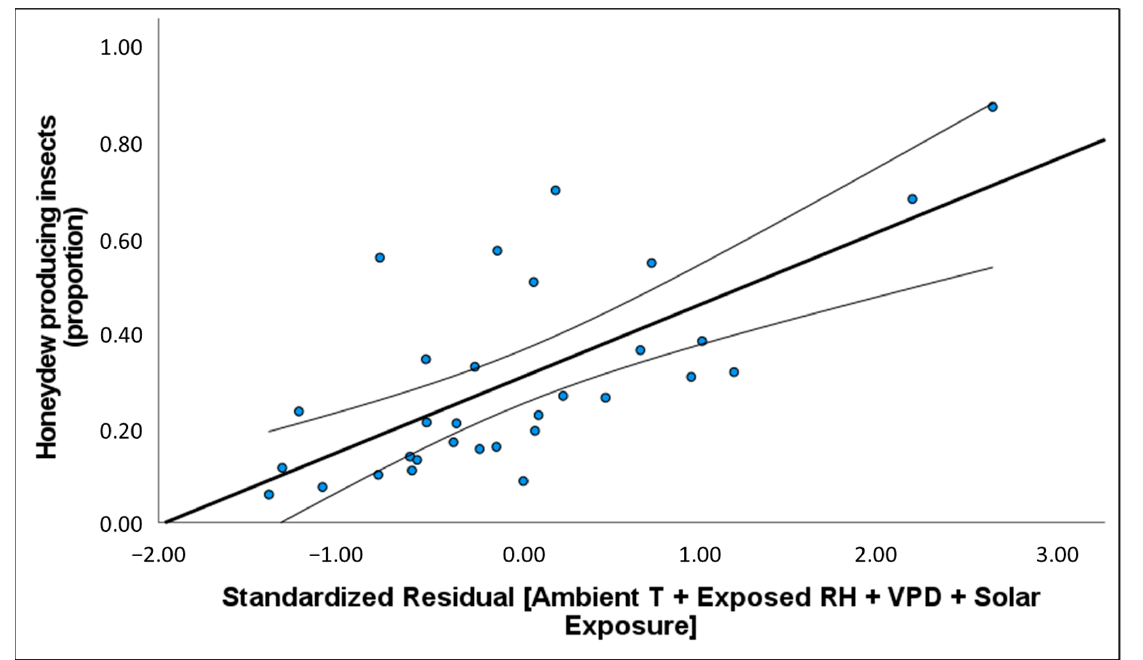
Figure A2. Scatterplot of the percentage of honeydew producing Marchalina hellenica plotted over standardised residual of best climate predictor variables with linear regression model plotted as curved black line. Curved black lines indicate 95% C. I. of the mean. Climate variables were selected